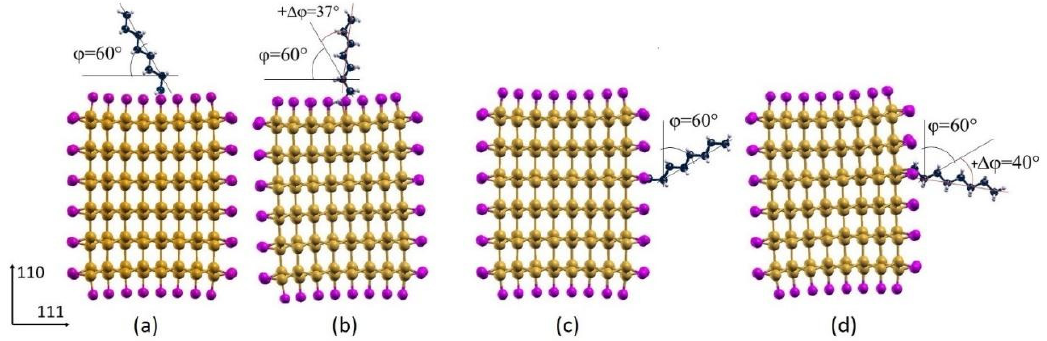
Figure 6. Initial ( a , c ) and optimized geometry ( b , d ) configurations of the octane moiety on the (111) ( a , b ) and (110) ( c , d ) surfaces of Cl-functionalized <112> oriented SiNWs (mustard color: Si atoms; magenta: Cl atoms; white: H atoms; blue: C atoms).